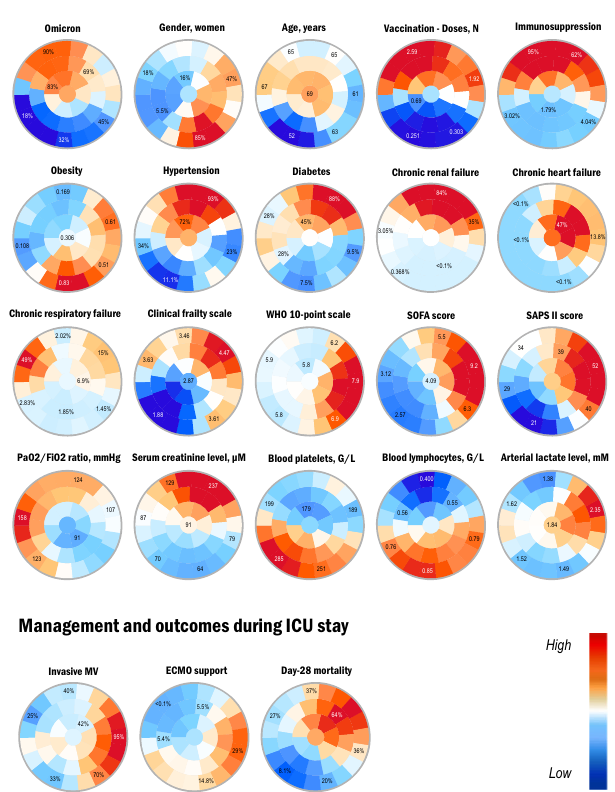
Fig. 3 | Unsupervised analysis of the clinical and biological characteristics of the patients infected with variants Omicron and Delta by self-organized maps (SOMs). Unsupervised analysisby SOM automatically located patients with similar clinical and paraclinical parameters within 1 of 40 small groupings ( “ districts ” ) throughout the map. The more similar the patients, the closer on the map. Each individual map shows the mean values or proportions per district for each char- acteristic: blue indicates the lowest average values, red the highest, with numbers shownforaselectionof representativedistrictsineachSOM.Inthe upperleftarea of the maps were located mostly Omicron-infected patients, as shown by the high prevalence rates (red colors) in this area of the Omicron map, whereas patients infected with variant Delta were distinctly located in the lower half area, as indi- cated by low Omicron prevalence rates (blue colors) in this area. Interpretation of thekeycharacteristicsassociatedwithOmicronversusDeltapatientscanbedrawn from the observationofthe othermaps:for instance,Omicron-infected patientsin the upperleftarea also hadhigher immunosuppression rates and meannumberof vaccination doses received as indicated by the red colors in the corresponding maps. WHO World Health Organization, SOFA Sequential Organ Failure Assess- ment, SAPS II Simpli fi ed Acute Physiology Score II, MV mechanical ventilation, Source data are provided as a Source Data fi